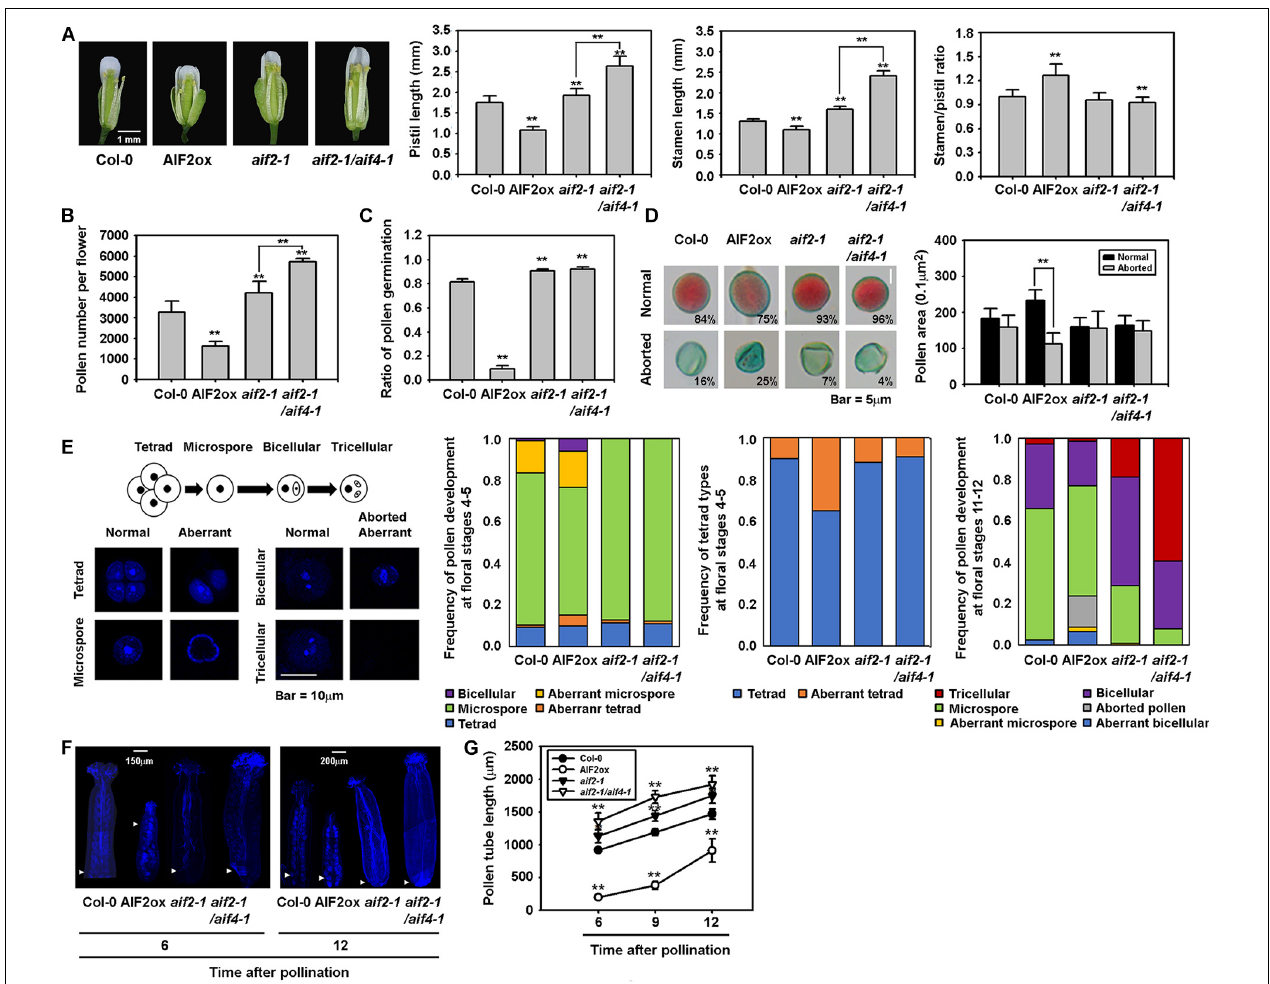
FIGURE 2 | Retarded growth of reproductive organs and degenerated pollen production and germination found in AIF2ox plants. (A) Flowers of Col-0, AIF2ox, aif2-1 and aif2-1/aif4-1 plants and the lengths of pistils, stamens, and the ratio of stamen to pistil. Number of open flowers examined > 30. (B) Measurement of pollen numbers counted under a bright microscope without pollen staining. Number of open flowers examined > 20. (C) In vitro pollen germination analysis. The efficiency of germination is represented by the ratio of germinated pollens after 6 h incubation in the germination medium. Number of pollens examined > 3,000 taken from 20–25 flowers. (D) Frequency and size of the Alexander solution -stained viable pollens (normal) and non-stained aborted pollens. Number of pollens examined > 2,000 taken from 15–20 open flowers (E) Defective pollen development in AIF2ox flowers. Pollens in different floral stages were stained with DAPI to reveal pollen developmental stages and pollens with intact nuclei (normal), without (aborted) or abnormal nuclei having defects in mitosis and appearance (aberrant). Number of pollens examined > 1,000 taken from flowers at stage 4–5 or stage 11-12. (F,G) In vivo pollen tube growth assay. Arrowhead indicates the end of aniline blue-stained pollen tubes at 6 or 12 h after hand-pollinated self-pollination in the same flowers (F) and lengths of pollen tubes at different times were measured after hand-pollination (G) . n > 15 for each time point was used for analysis. Statistical difference from either the Col-0 control or bracketed samples is indicated by two asterisks (**) at P <